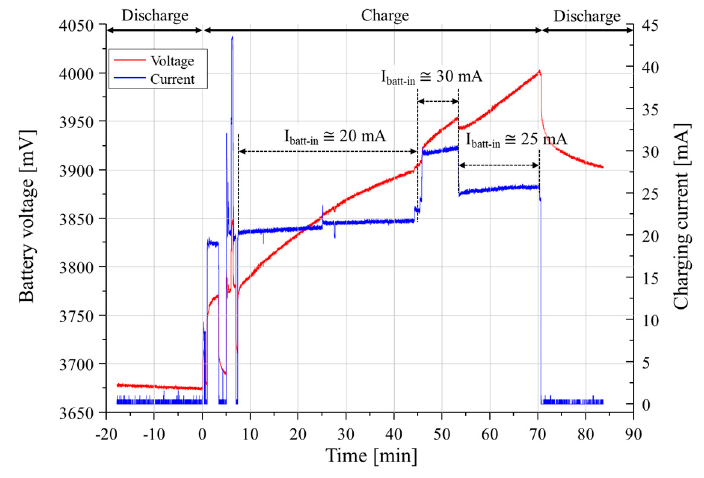
Figure 17. Measured voltage and current profile of the battery. The charging was conducted at 20 mA for 45 min, 30 mA for another 10 min, and then maintained at 25 mA for the last 15 min.